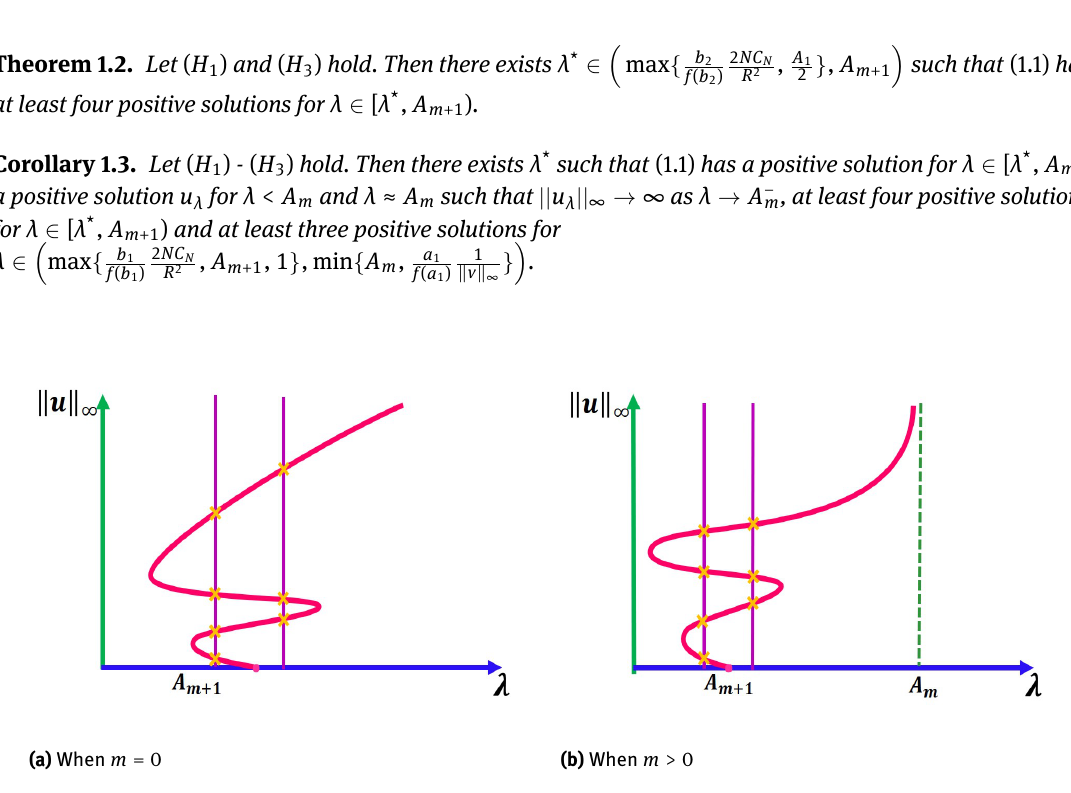
Fig. 3: An expected bifurcation diagram for (1.1) when hypotheses of Corollary 1.3 are